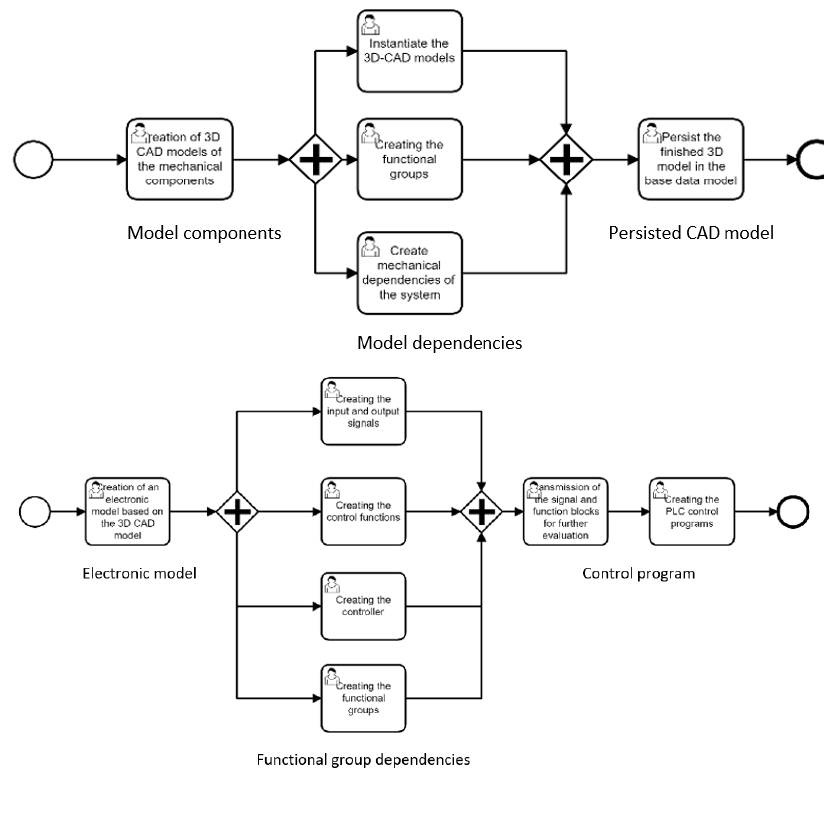
Figure 7. Sequence of steps for DT development model derived from [11] Green: off-line, yellow: on-line activity.